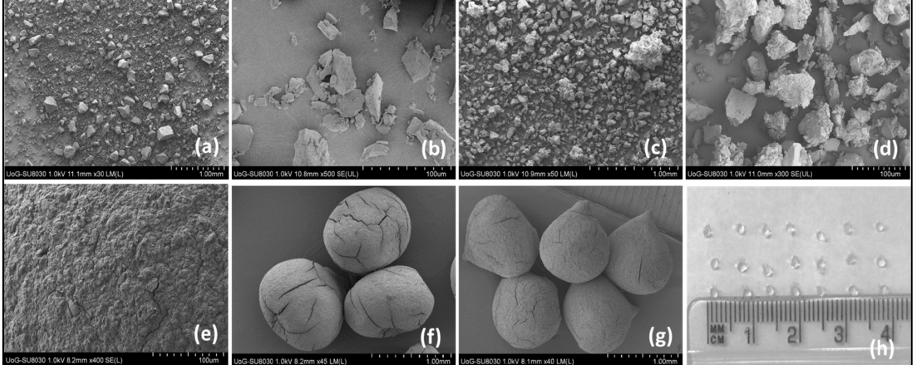
Figure 10. Secondary electron images of ( a , b ) LP, ( c , d ) LP-TP, ( e ) LP-TP-SA bead surface, ( f , g ) LP-TP-SA dried beads, and ( h ) digital photograph of LP-TP-SA beads.